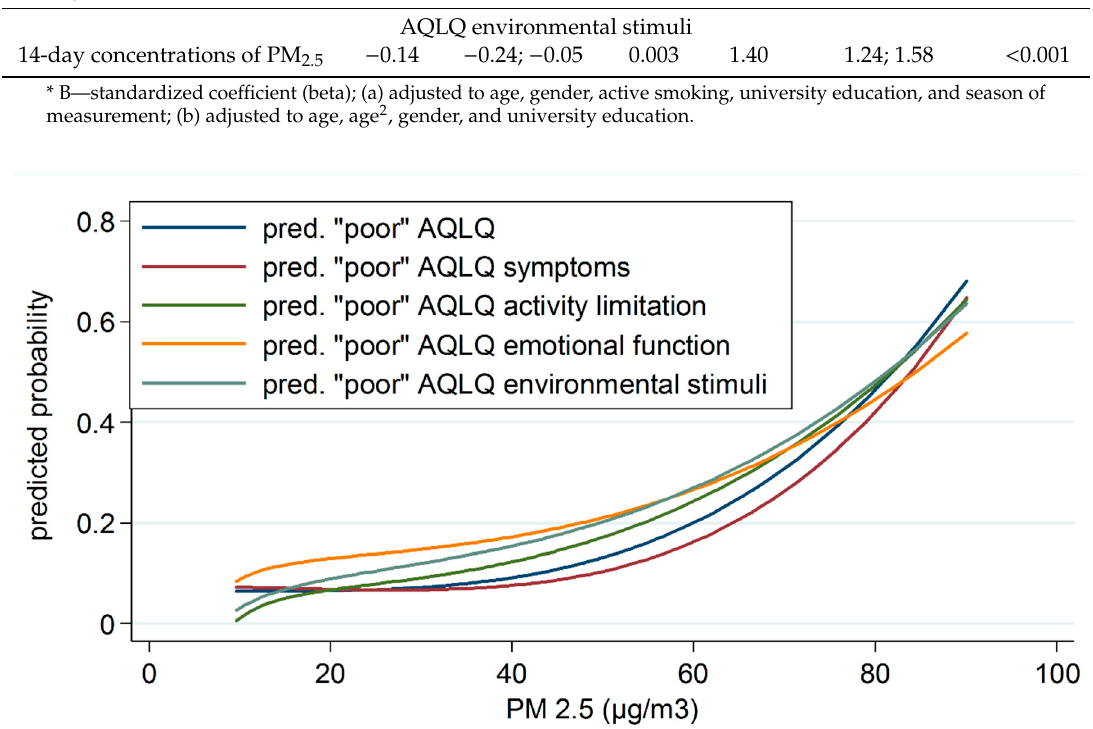
Figure 2. Predicted probabilities of “poor” asthma quality of life (total and for specific domains) according to PM 2.5 levels.